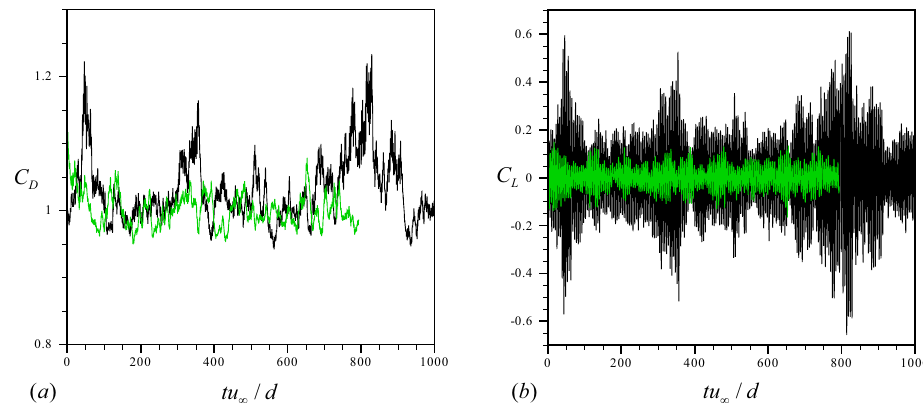
Figure 15. Time histories of drag and lift coefficients with and without tabs: ( a ) drag coefficient; ( b ) lift coefficient. Black line, cylinder without a tab; green line, cylinder with tabs of l y / d = 0.2 and l z / d = 0.3, and λ z / d = 4 in a staggered